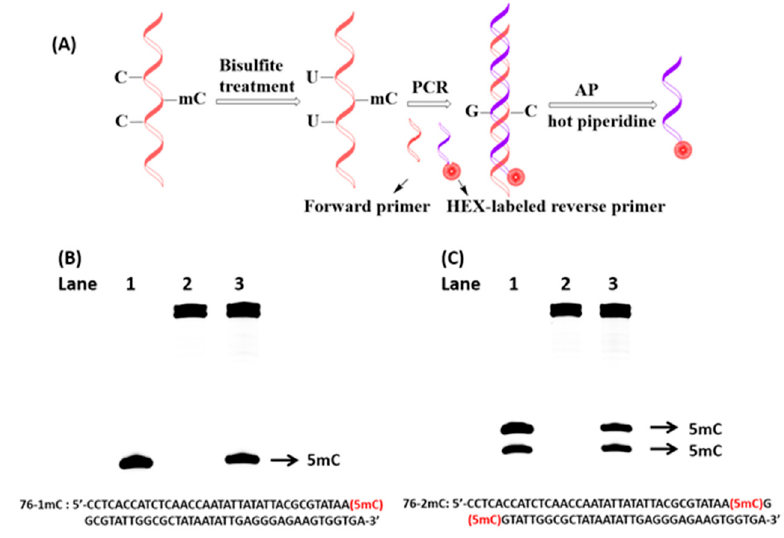
Figure 6. ( A ) Schematic illustration of detection of the loci of 5-methylcytosine in DNA by PCR, the product of PCR was treated with AP and hot piperidine; ( B , C ) Poly-acrylamide gel electrophoresis analysis of 76-mer template containing one or two 5-methylcytosine sites. Lane 1: marker; lane 2: PCR product without treatment; lane 3: PCR product treated with AP and hot piperidine.